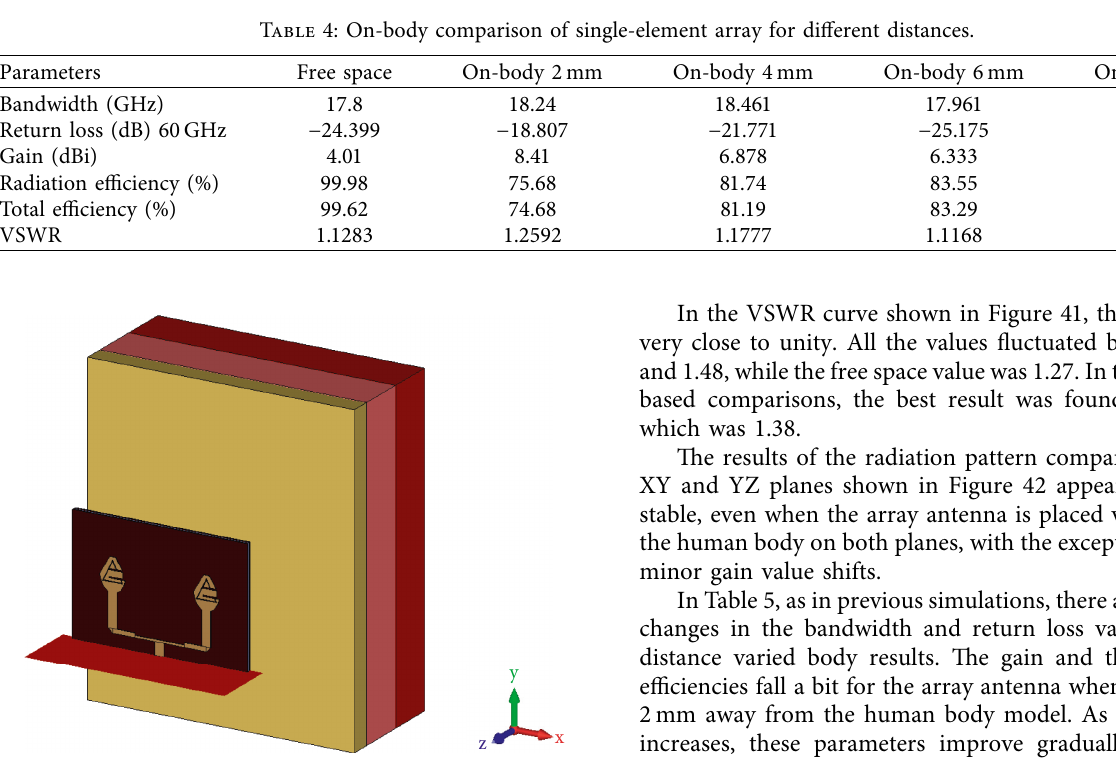
Figure 39: On-Body simulation setup for 1 × 2 antenna